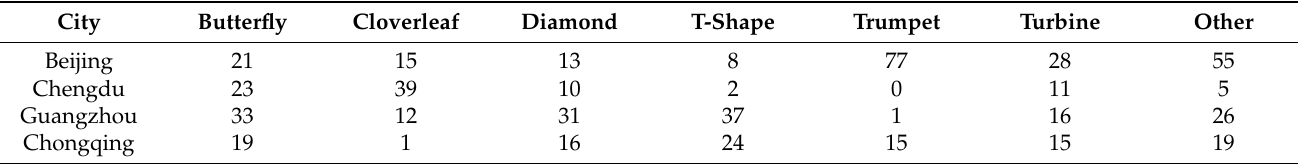
Table 7. Statistics of the detected complex junctions in the four cities.